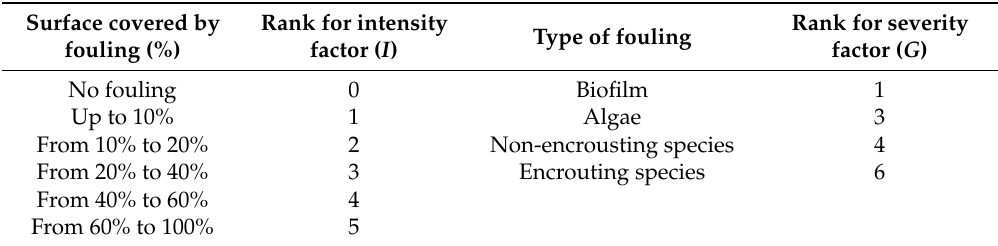
Table 2. Type of marine macrofouling organisms settled on substrates immersed in seawater. Ranking of the intensity and severity